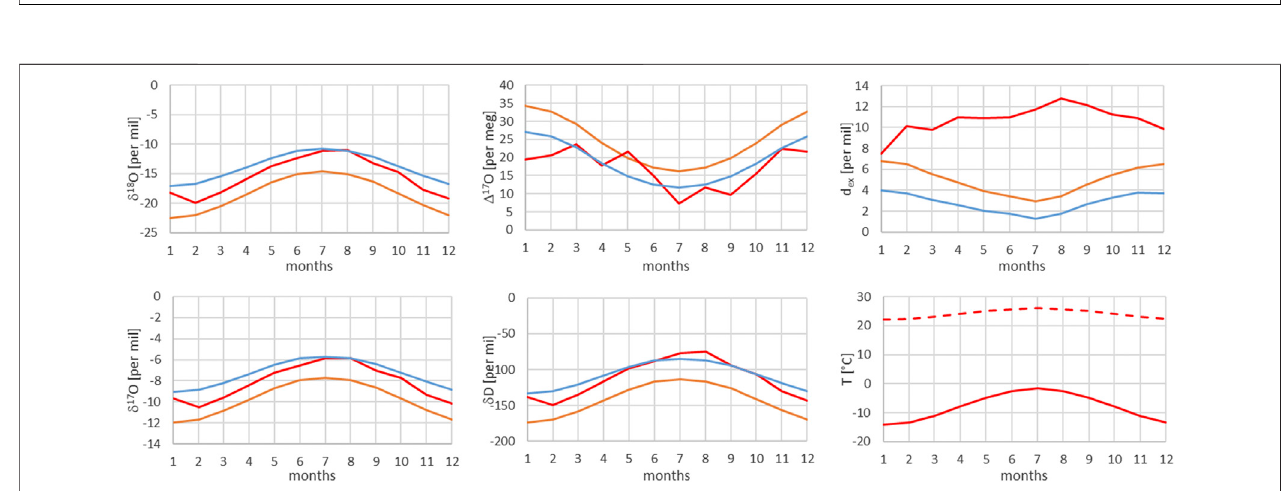
FIGURE 13 | Comparison of monthly mean measured (red) and modeled (for the isobaric case (orange) and for the dry adiabatic case (blue)) isotope ratios for Jungfraujoch (JFJ). The dashed red line corresponds to the assumed source temperature.